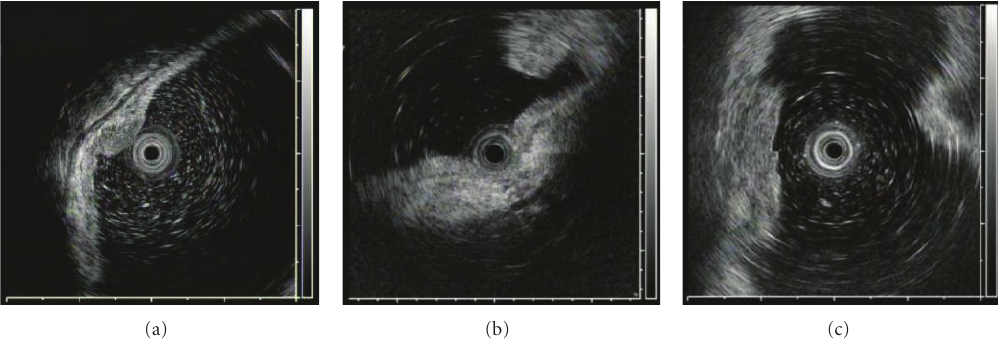
Figure 1: Representative EUS images for evaluating EUS image score. (a) An EUS image fulfilling the three characteristics, including “repeatability of detection,” “appropriate probe placement,” and “clarity of the five layers of the gastric wall including the lesion”; (b) Inappropriate placement of the probe. The EUS probe is pressed on the lesion; (c) the five layers of the gastric wall including the lesion are not